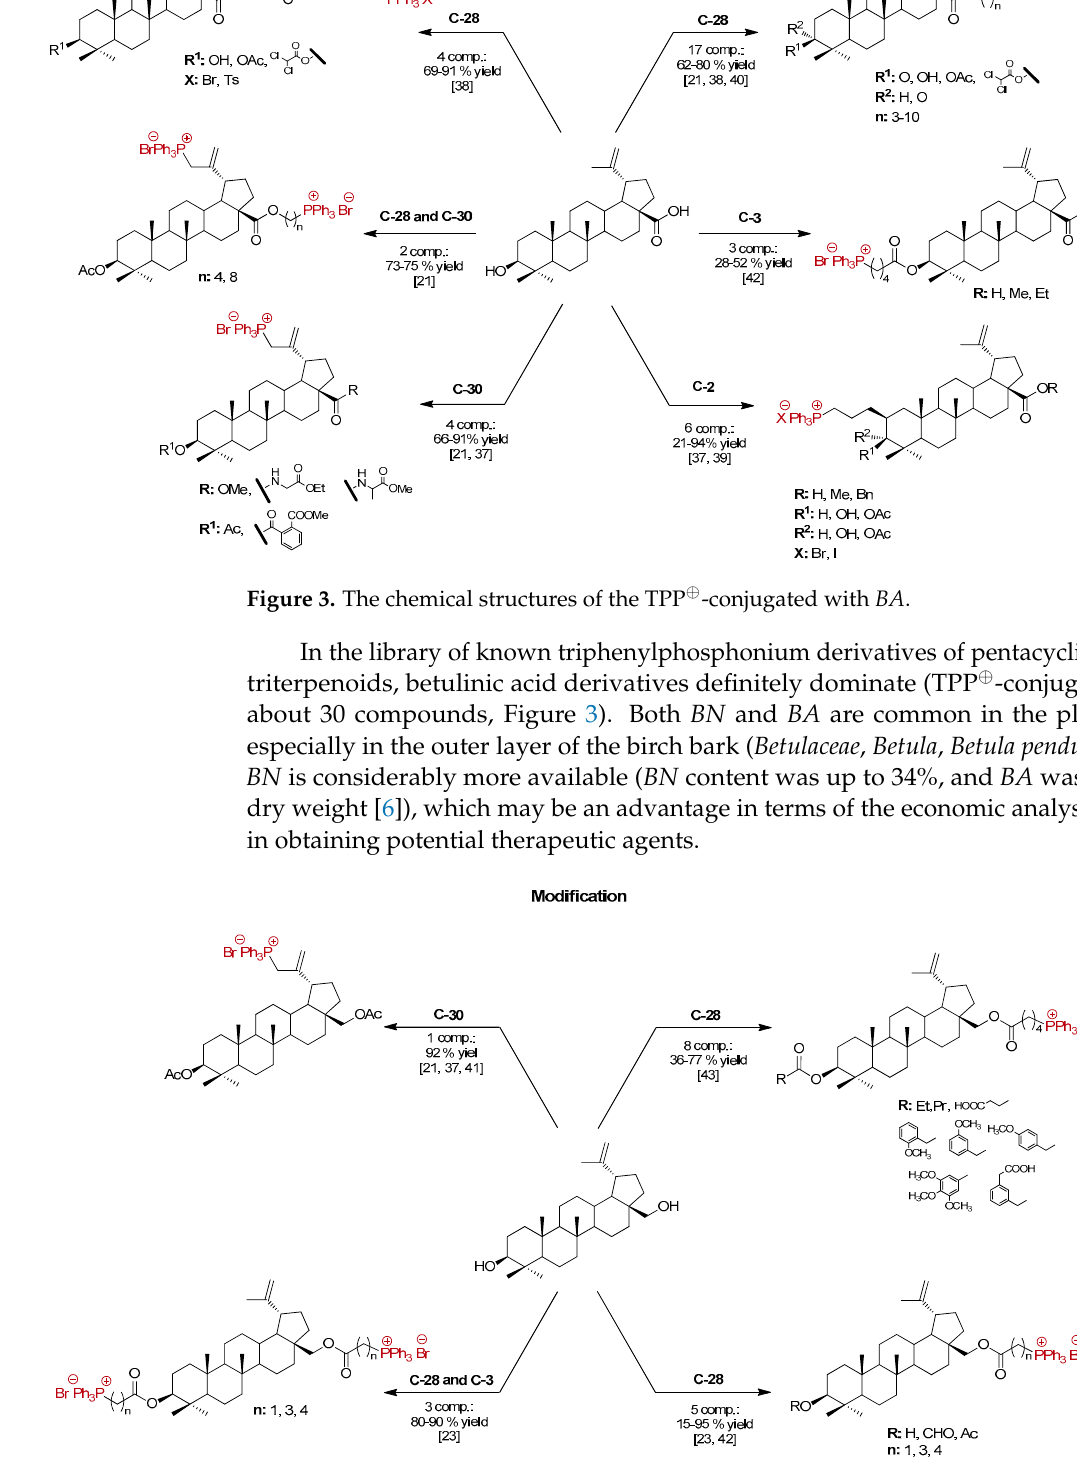
Figure 4. The chemical structures of the TPP ⊕ -conjugated with BN .